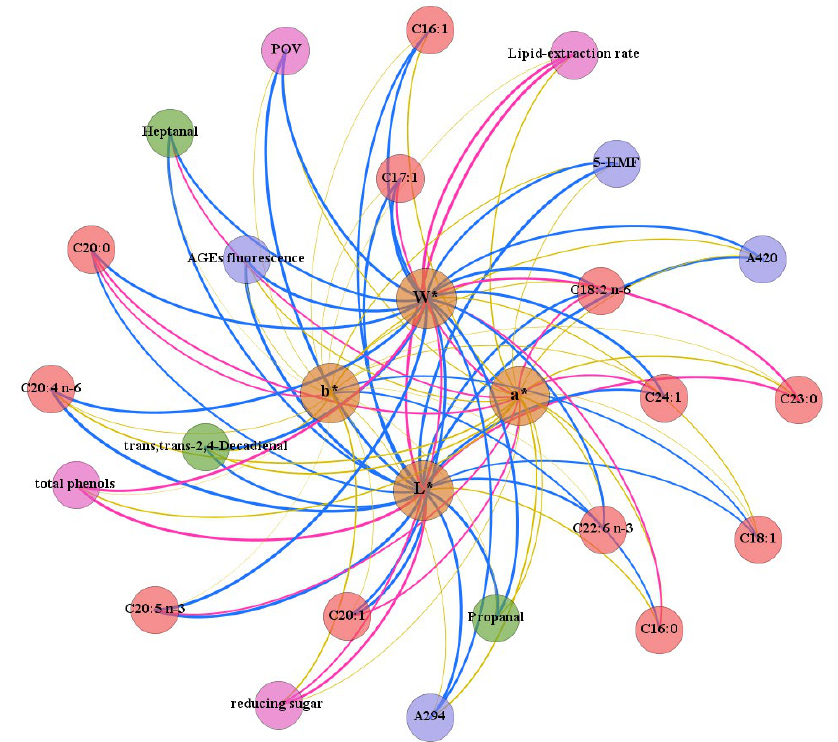
Figure 4. The correlation network between color parameters and related impact indicators of RTE abalone during storage. Brown nodes represent color parameters, while other nodes represent relevant impact indicators. The thickness of the line is proportional to the Pearson correlation value. The pink line and blue line indicate positive correlation and negative correlation, respectively, and the yellow line indicates weak correlation.